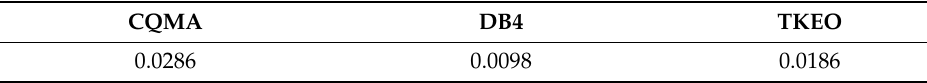
Table 3. Characteristic frequency intensity values.